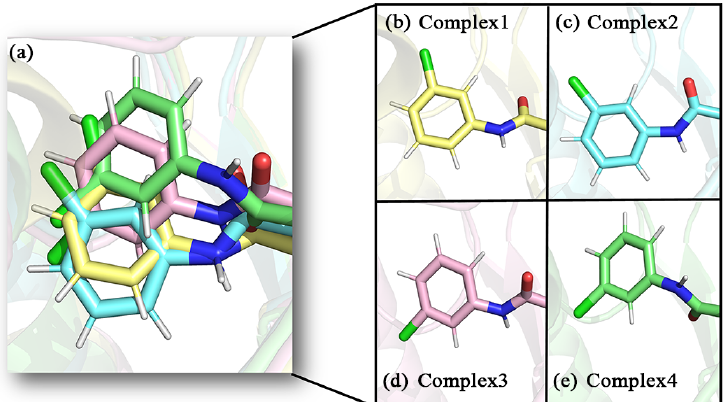
Figure 8. Enlarged detail showing the direction of the tail benzene ring in the four complexes, ( a ) superimposed diagram of the four complexes, ( b – e ) detail of the four complexes in the benzene ring direction.